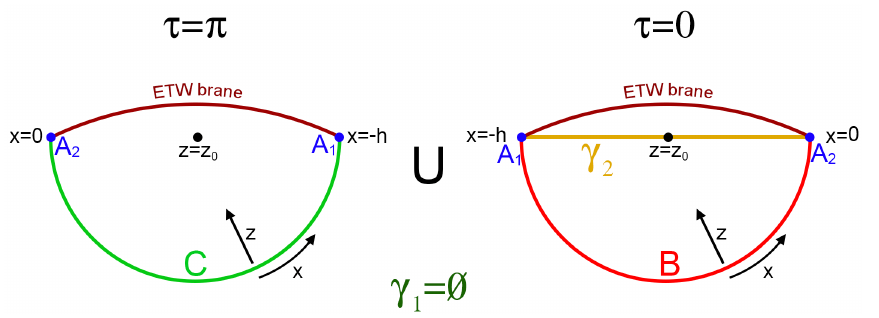
is always dominant. 2